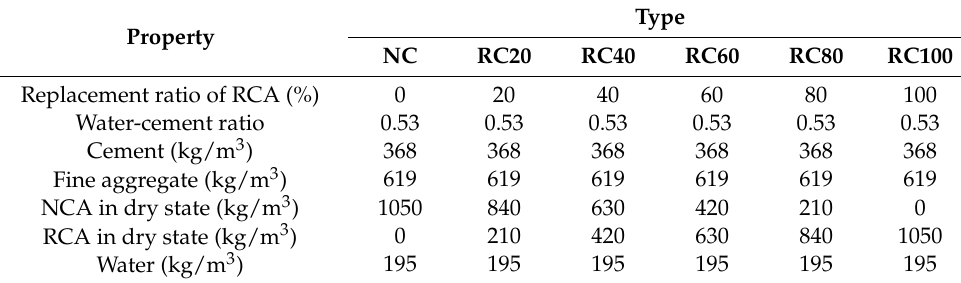
Table 3. Design mixture proportions of